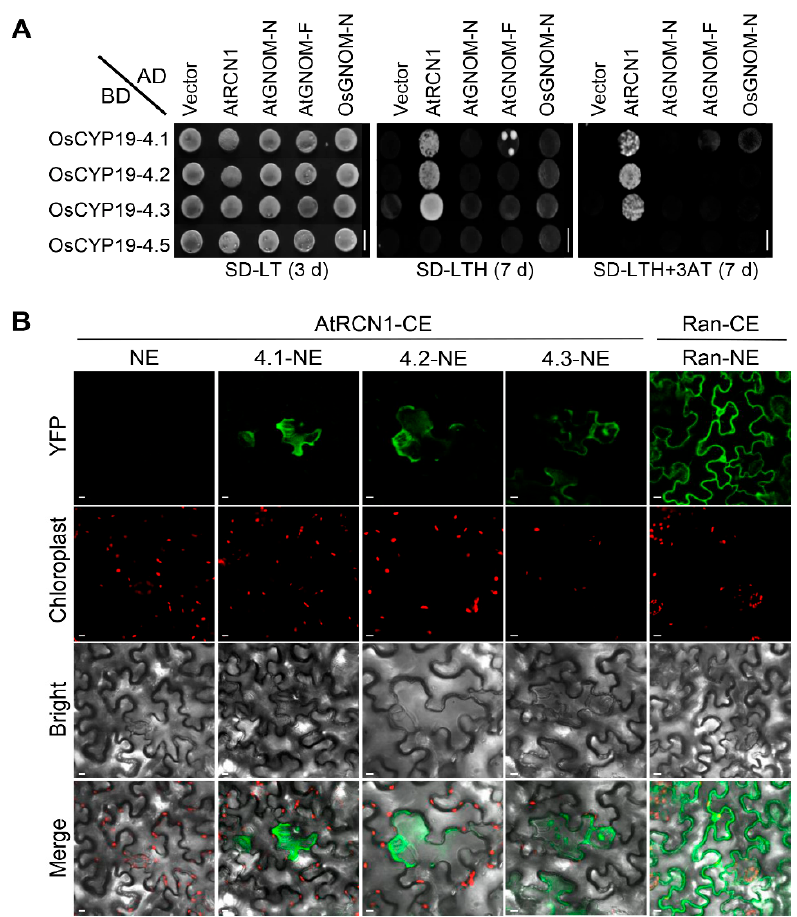
Figure 4. Specific protein-protein interactions between OsCYP19-4 isoforms and AtRCN1 in vivo. ( A ) Yeast two-hybrid analysis of OsCYP19-4 AS isoforms with AtRCN1, AtGNOM-N, N-term (AtGNOM-N: aa 1-250); AtGNOM-F full length (AtGNOM-F: aa 1-1451), and OsGNOM-N, N-term (OsGNOM-N: aa 1-250). Specific protein-protein interactions occur between AtRCN1 and OsCYP19-4.2/3, but not OsCYP19-4.5. Scale bars = 0.7 cm; ( B ) Visualization of OsCYP19-4 AS isoforms and AtRCN1 interactions using bimolecular fluorescence complementation (BiFC). Images show YFP fluorescence signals (green color) from AtRCN1 interacting with OsCYP19-4.1 (4.1-NE), OsCYP19-4.2 (4.2-NE), or OsCYP19-4.3 (4.3-NE). Chlorophyll autofluorescence is shown in red color. All images are single confocal sections. Scale bars = 10 μ m.